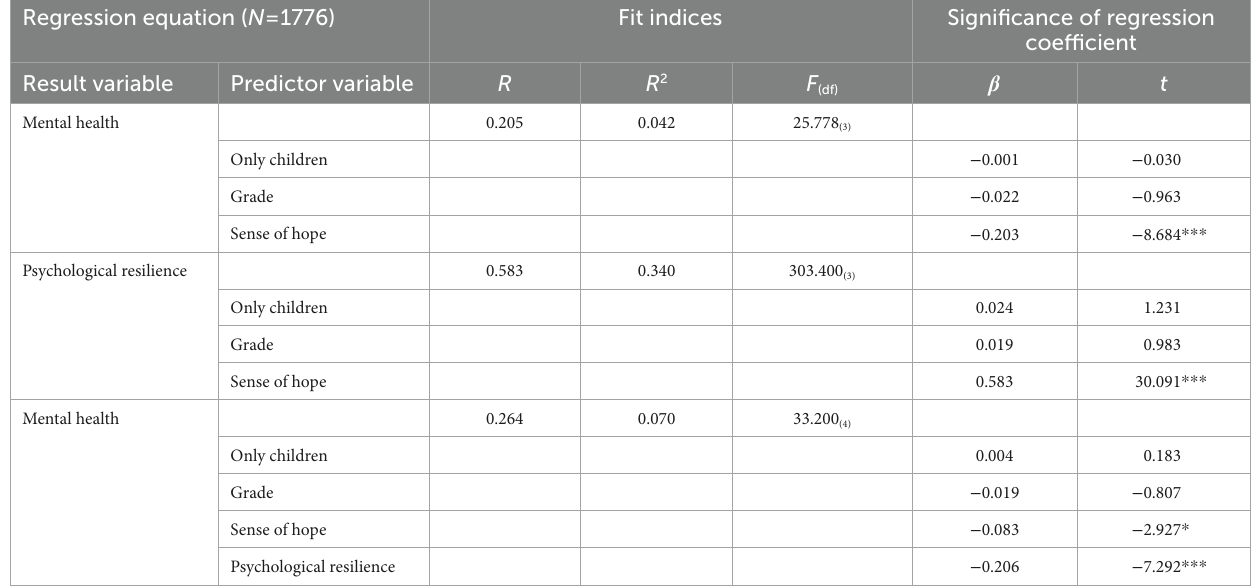
TABLE 2 The mediating effect of the psychological resilience on the relationship between sense of hope and mental health. Regression equation ( N = 1776) Fit